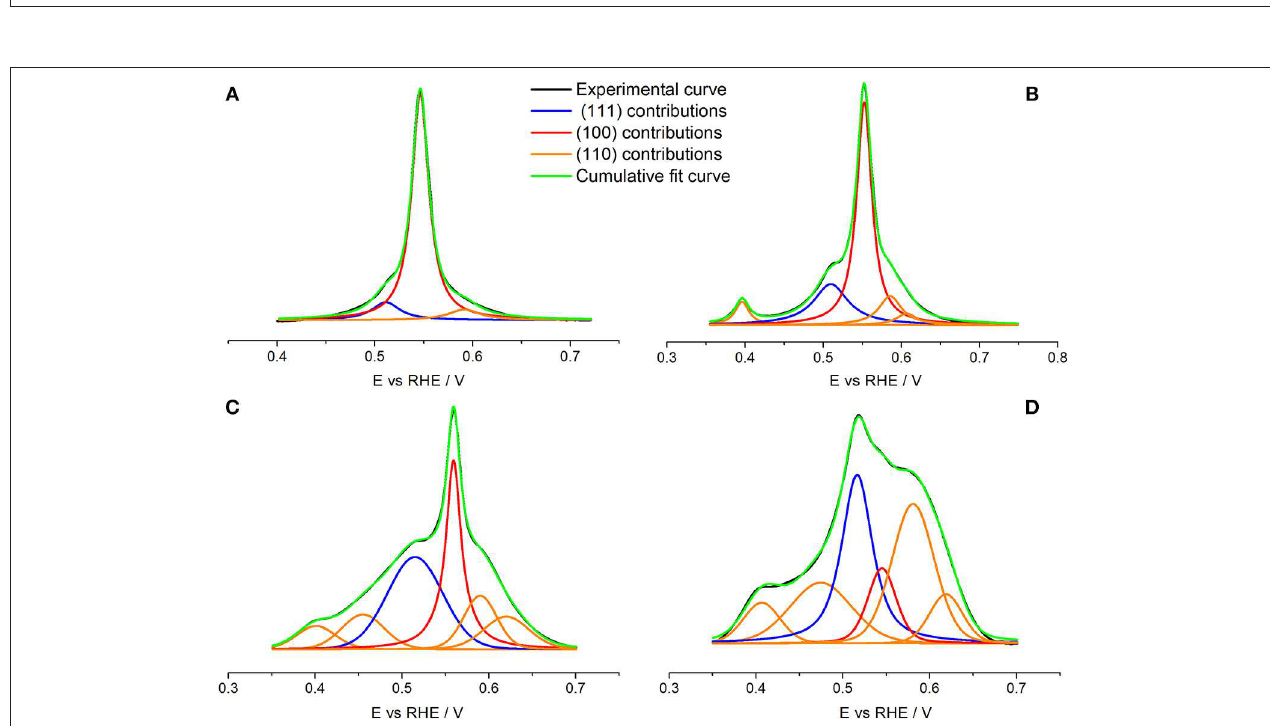
FIGURE 8 | Cu UPD deconvolution with pseudo-Voigt function for (A) Pd Cub , (B) Pd 20 Cub , (C) Pd 10 Cub , and (D) Pd 3 Sp nanoparticles. Test solution 0.1M H 2 SO 4 + 1mM Cu 2 + + 1mM NaCl, scan rate 50mV s − 1 .